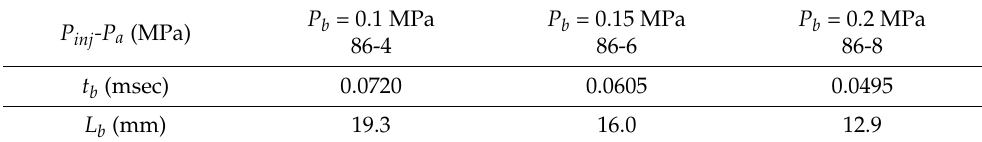
Table 10. Boost pressure effect of breakup time and length.